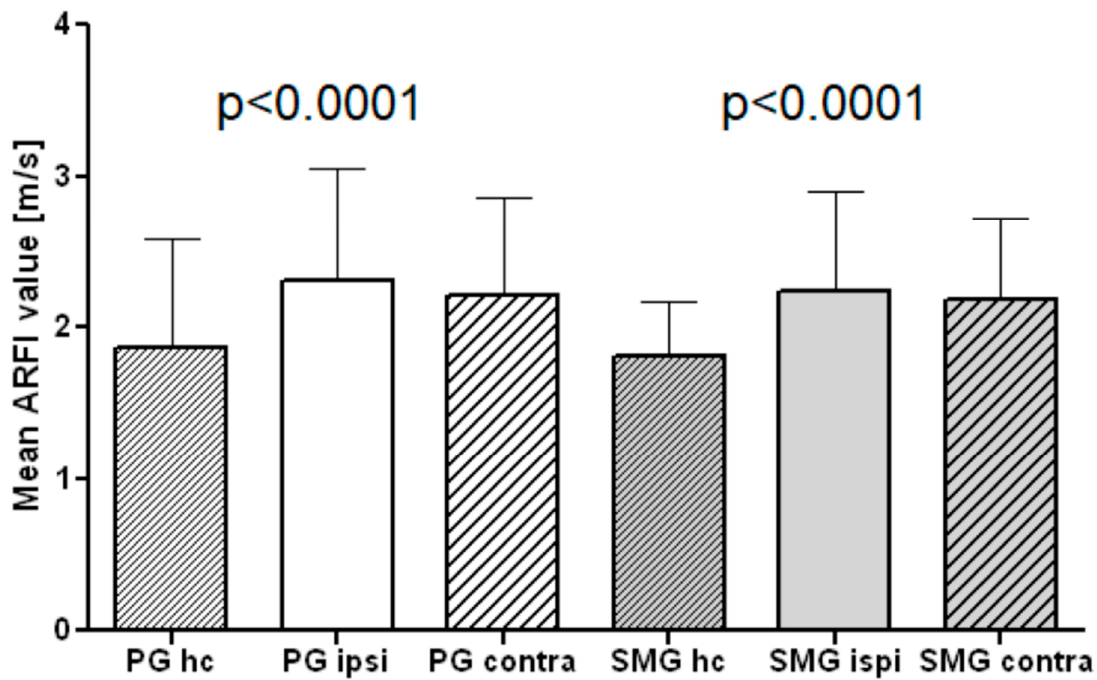
Figure 1. Point shear wave elastography (pSWE) imaging values of parotid glands (PG) and sub- mandibular glands (SMG) ipsi- and contralateral of patients compared to 50 healthy controls (HC).